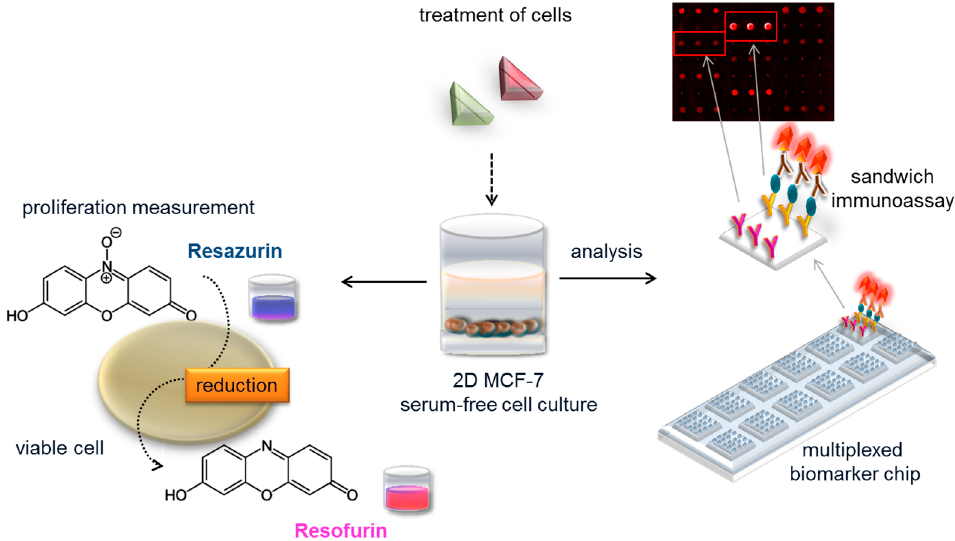
Figure 1. Experimental setup of the biomarker chip and proliferation platform. MCF-7 cells in serum-free cell culture are exposed to e.g., food samples containing estrogen receptor agonists and antagonists; biomarkers released are quantified in supernatant with a multiplexed protein microarray based on fluorescence detection. The on-chip sandwich immunoassay employs immobilized antibodies to capture the biomarker and a fluorescently labeled detection antibody for read out. In parallel, the proliferative effect in hormone-sensitive cancer cell line MCF-7 is measured with a resazurin assay.